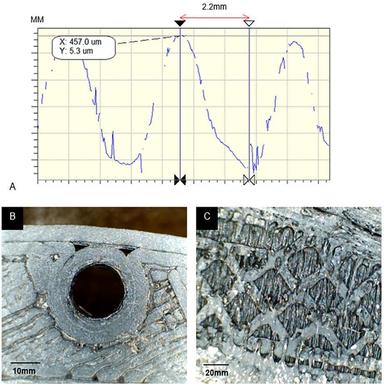
(A) Roughness scan across the surface of the optimised profile generated at a deposition speed 4 mm/s and 3 second hold-off (B) the production of a 15 mm diameter hole and resulting infill and (C) formation of the complex infill pattern formed to improve structural integrity of the combustion chamber.